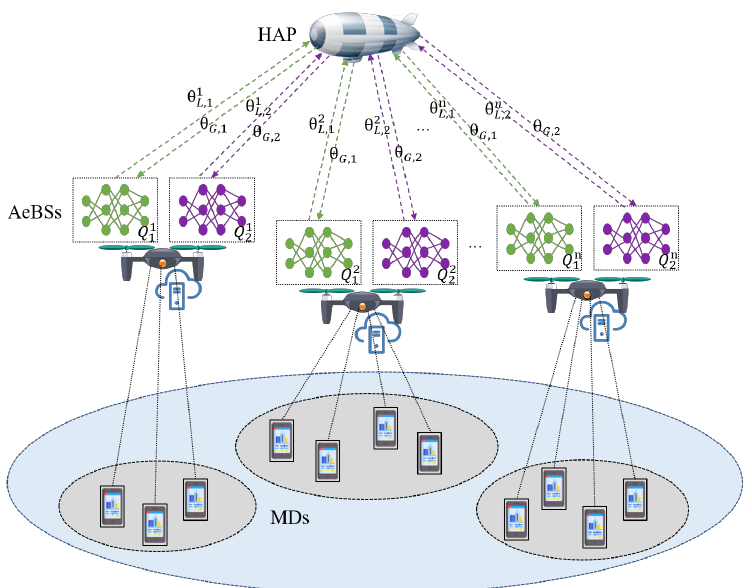
Figure 1. Federated deep-reinforcement-learning-based joint computation offloading and deploy- ment